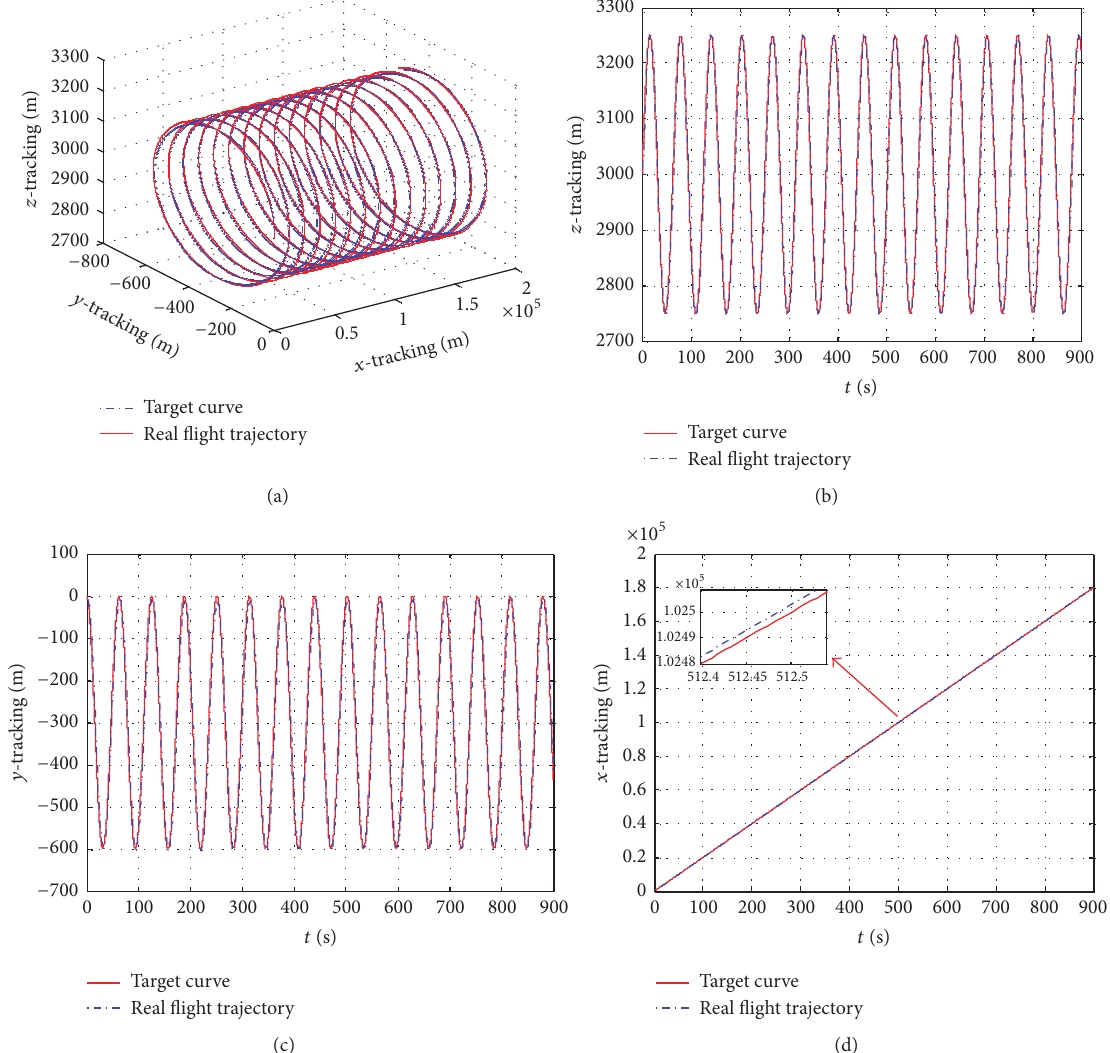
Figure 5: (a) 3D trajectory tracking result, (b) tracking curves in the vertical direction, (c) tracking curves in the lateral direction, and (d) tracking curves in the forward